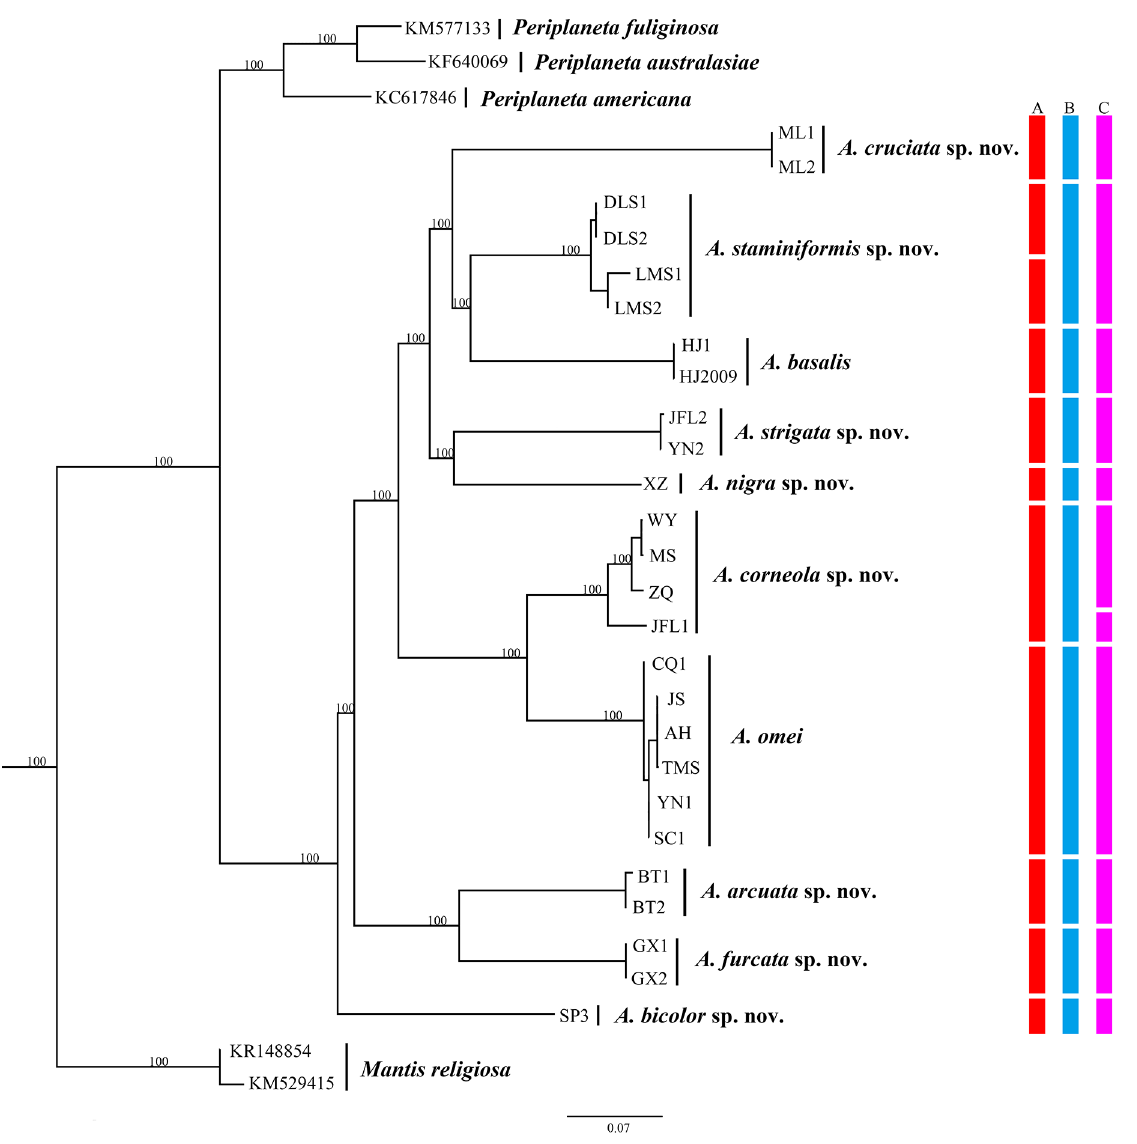
Fig. 1. Maximum-likelihood (ML) tree derived from COI gene analysis following GTR GAMMA model with 1000 bootstrap replicates. Colored bars in red refer to the morphospecies, those in blue to MOTUs in ABGD and those in purple to MOTUs in